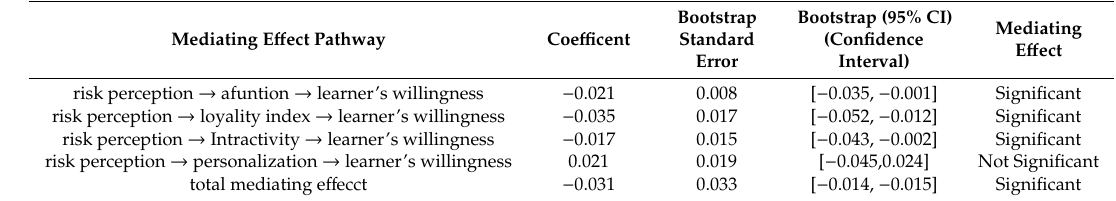
Table 3. Results of the mediating e ff